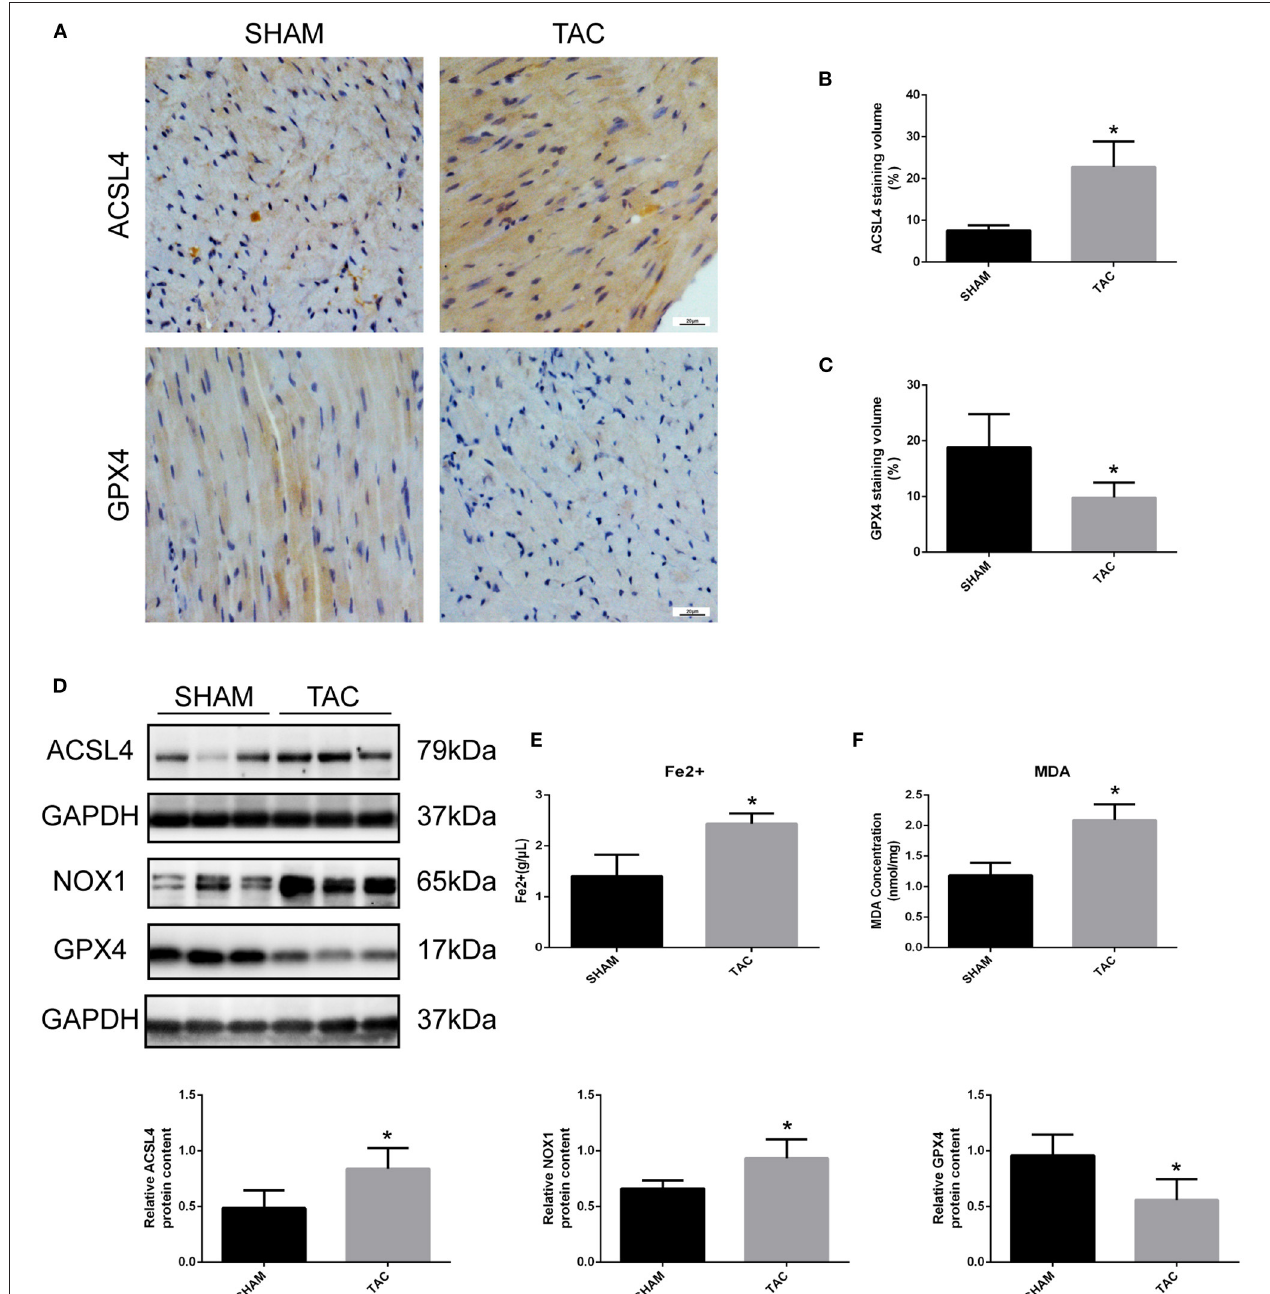
FIGURE 4 | Detection of ferroptosis-associated genes in TAC mice. (A–C) Representative immunohistochemical staining images and quantitative data of ACSL4 and GPX4 in myocardial tissues. (D) Representative Western blot image and quantitative data of ACSL4, NOX1 and GPX4 in myocardial tissues. The concentrations of ferrous ion (E) and MDA (F) in TAC mouse heart tissues. * P < 0.05.